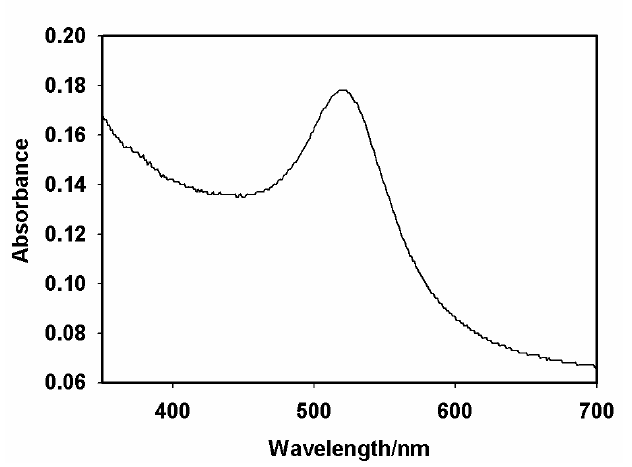
Figure 1. UV-Vis spectrum of colloidal gold nanoparticles.